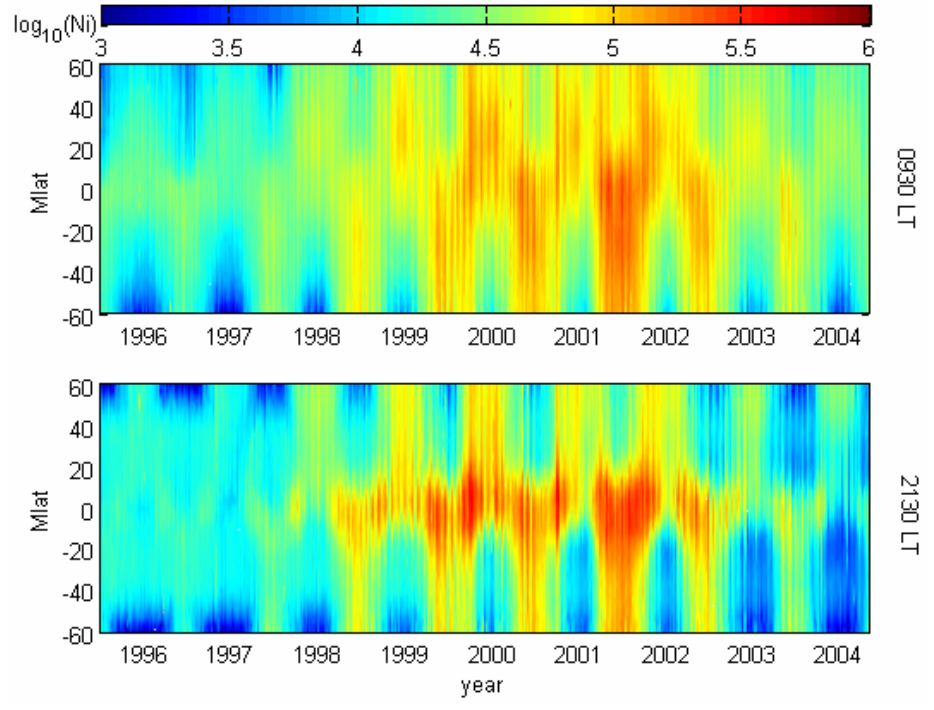
Fig. 2. Ion density distribution at magnetic latitudes –60 ◦ ∼ 60 ◦ for the period 1996–2004 at 09:30 LT and 21:30 Figure 2. Ion density distribution at magnetic latitudes -60°~60° for the period 1996-2004 at 0930 LT and 2130 LT.